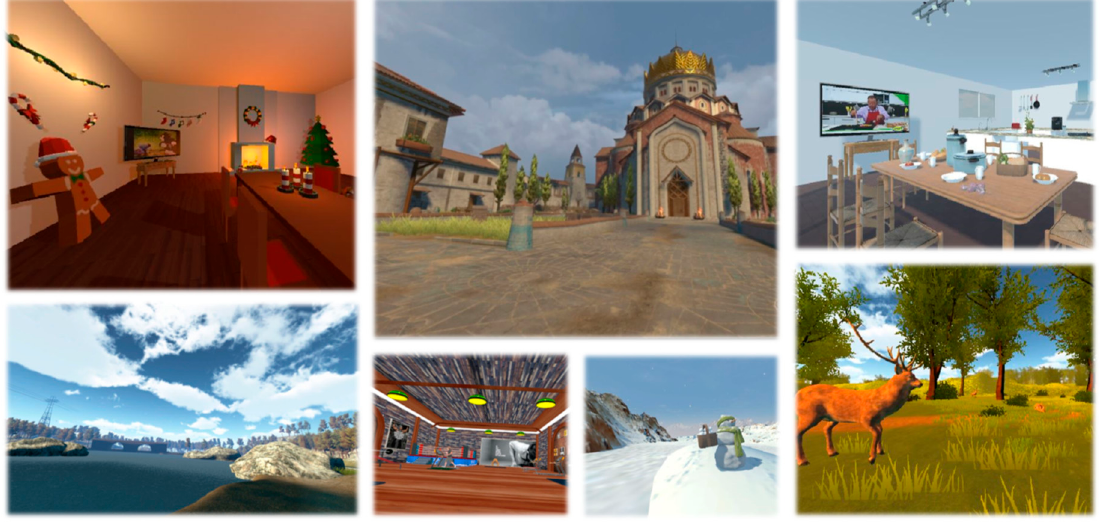
Figure 2. Snapshots of representative VEs.